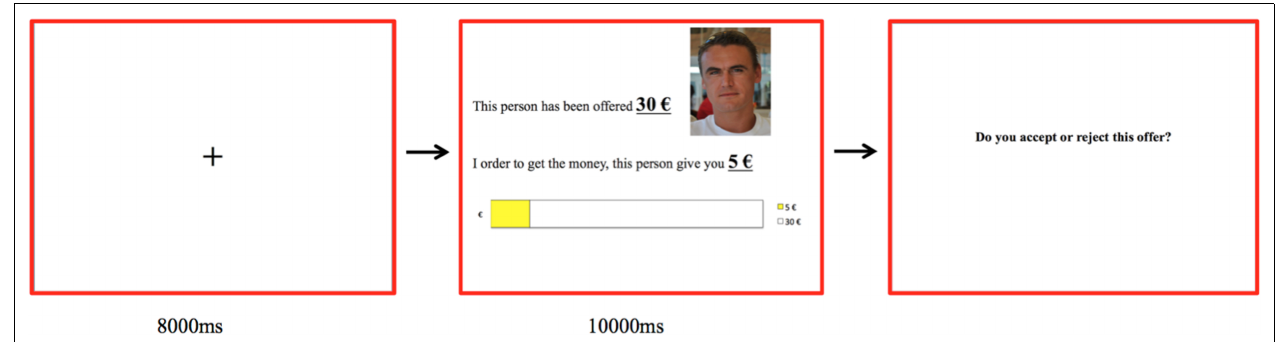
FIGURE 1 | Timeline for a single trial of the ultimatum game. The original screens were in